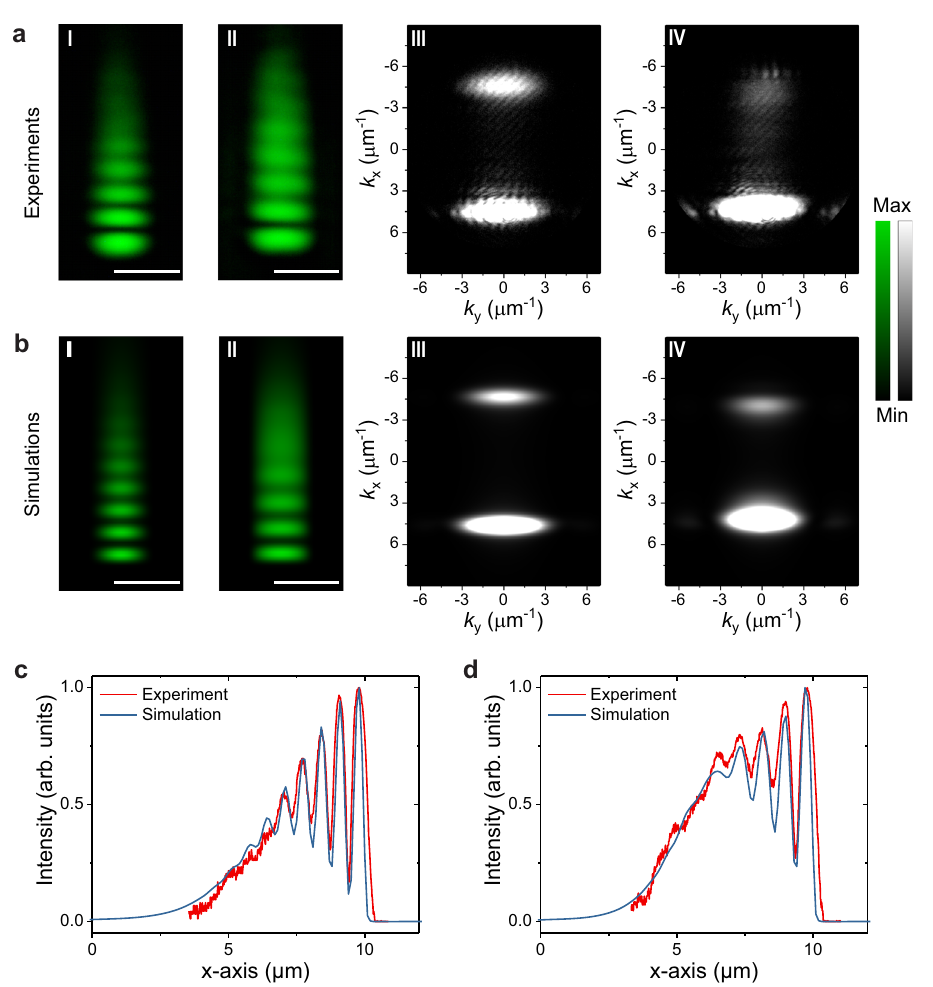
Fig. 3 | Room-temperature demonstration of one-dimensional polariton supersonicregime.a -I, a -II( a -III, a -IV)Experimentalreal-space(momentum-space) images of polariton fl uid with resonance pumping power in the cavity of 0.08 (I) and 6.76 (II) μ J cm − 2 , respectively.With largerinjectionmomentumof4.6 μ m − 1 ,the polariton fl uidwasstillinsupersonicregime at highpolaritondensity, asshownby the interference fringes and scattering signals in a -II and a -IV. b -I, b -II ( b -III, b -IV)